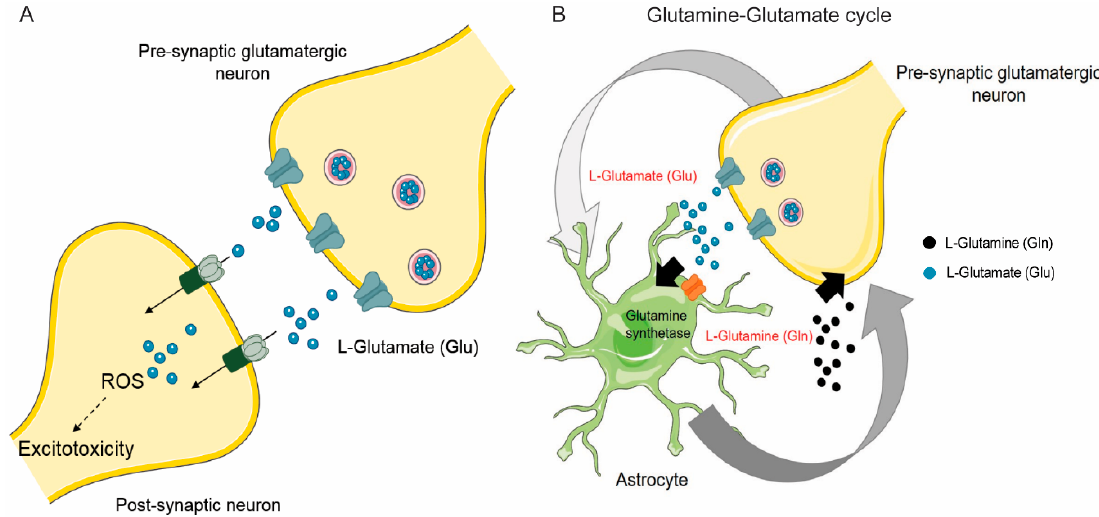
Figure 1. Glutamine / Glutamate neuroglial cycle and glutamate-induced excitotoxicity. ( A ) Pre-synaptic glutamatergic neurons utilize glutamine to synthesize the excitatory neurotransmitter, glutamate, which is then released during synaptic transmission. Glutamate then interacts with post-synaptic glutamatergic receptors. Excess glutamate however, leads to oxidative stress and neuronal injury, termed as excitotoxicity. ( B ) Astrocytes help mitigate glutamate-induced excitotoxicity by removing glutamate from the synapse. Glutamate is then converted to glutamine by the enzyme glutamine synthetase, an enzyme that is present in astrocytes but not in neurons. Glutamine is recycled to neurons to enable glutamate synthesis. Abbreviations: ROS, reactive oxygen species.